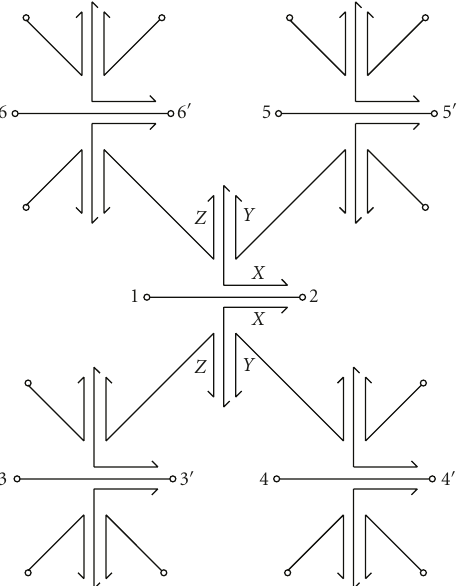
Figure 11: Five precision couplers configured for 2 × 2 array cali-